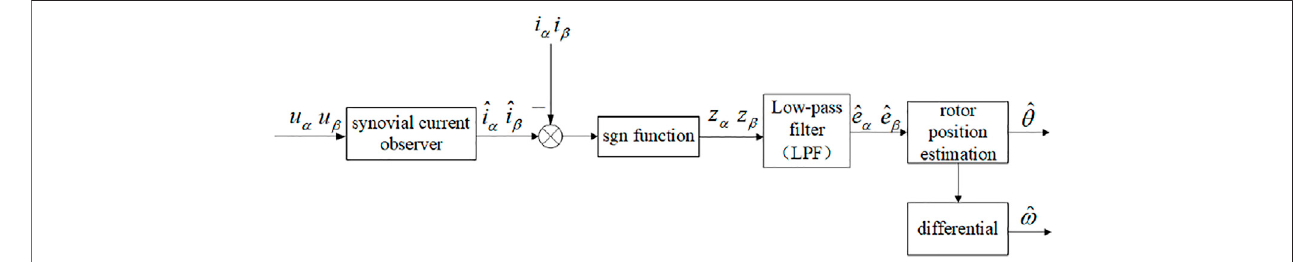
FIGURE 3 | Control structure block diagram of the synovial current